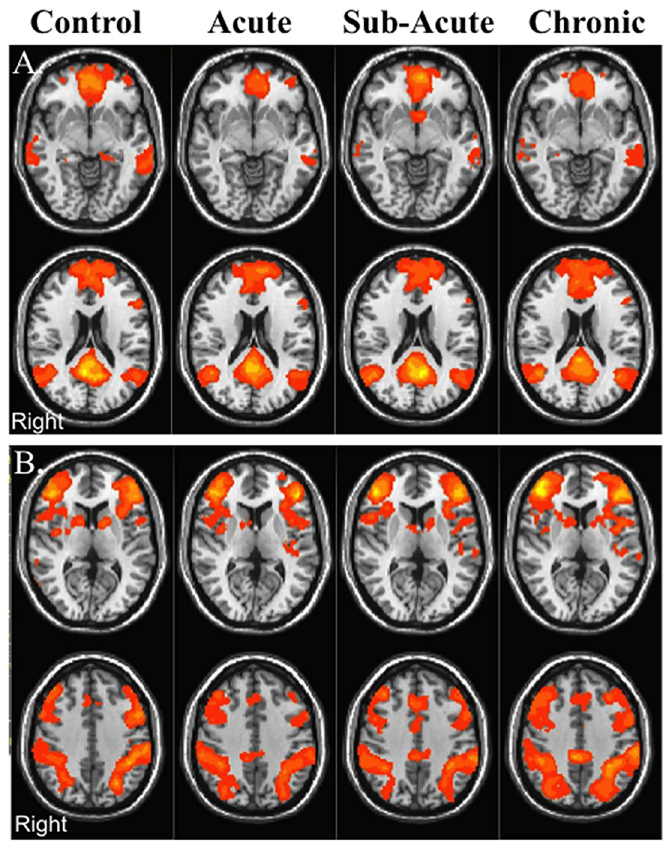
Fig 2. Within group rs-FC maps for control participants and mTBI patients. (A) Default Mode Network (DMN). (B) Task Positive Network (TPN). Maps are thresholded at a voxel wise p -value of 0.001 (uncorrected) and cluster extent threshold of p -value of 0.001 using a family wise error correction for multiple